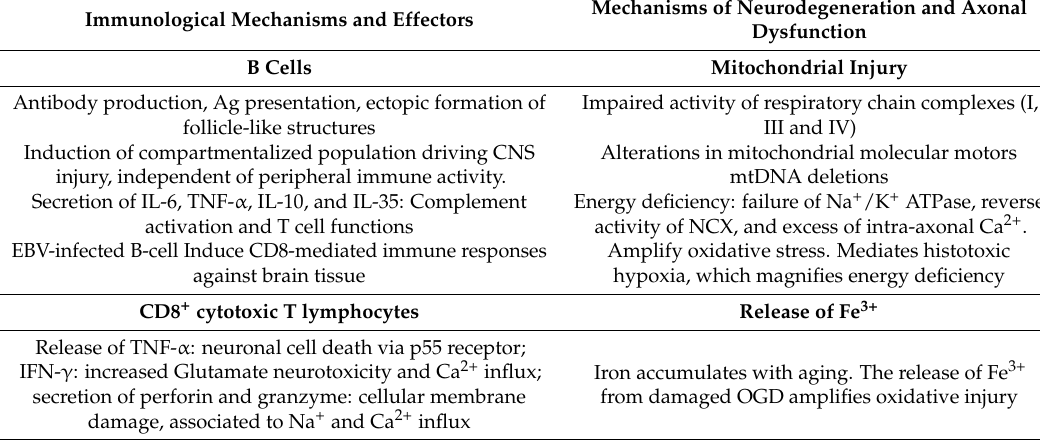
Table 1. Mechanisms proposed to explain Multiple Sclerosis